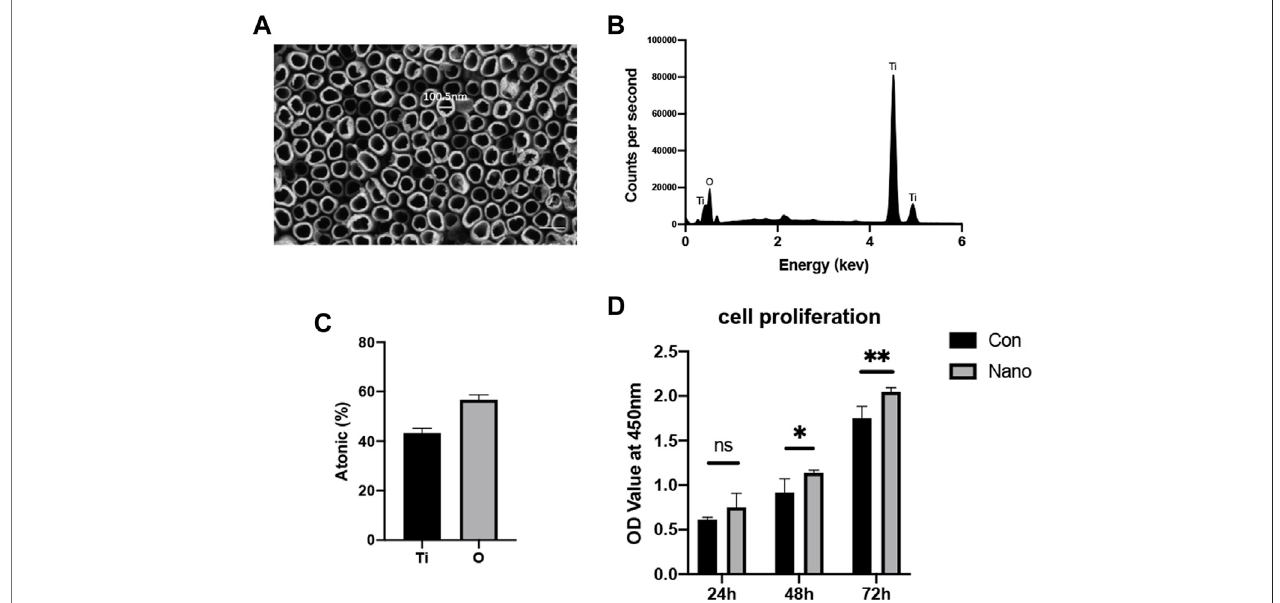
FIGURE 1 | Nanotopography surface characteristics and biocompatibility. (A) Lumen structure of nanotubes observed by SEM with a diameter of approximately 100 nm. Scale bar: 200 nm. (B) EDS analysis of the chemical element composition of nanotubes. (C) Ti and O element ratio on nanotopography. (D) CCK8 test of BMSCs seeded on nanotubes and smooth titanium. * p < 0.05, ** p <